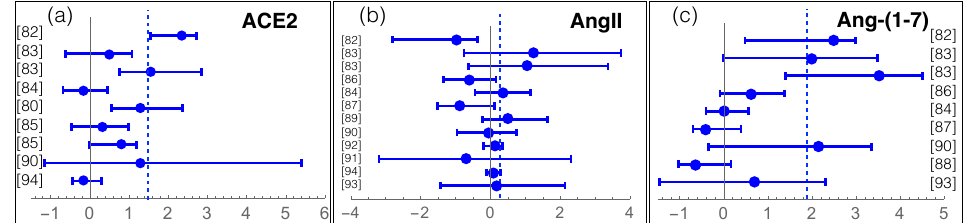
Figure 3. Log-ratios between RAS components (ACE2, AngII and Ang-(1-7)) in COVID-19 patients and controls, with the estimated confidence intervals, for all the collected studies referenced by their reference number (see Table S1). The dashed lines represent the averages of the log-ratios weighted according to the number of patients analyzed in each study. On the y-axis, the reference to the study is